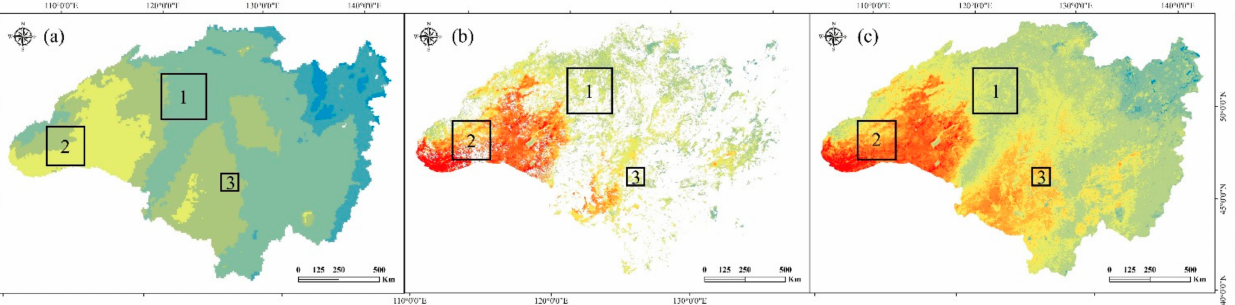
Figure 9. Demonstration of gap filling on DOY 185 (4 July 2010): the ERA5ST ( a ), original MODIS LST ( b ), and gap-filled MODIS LST ( c